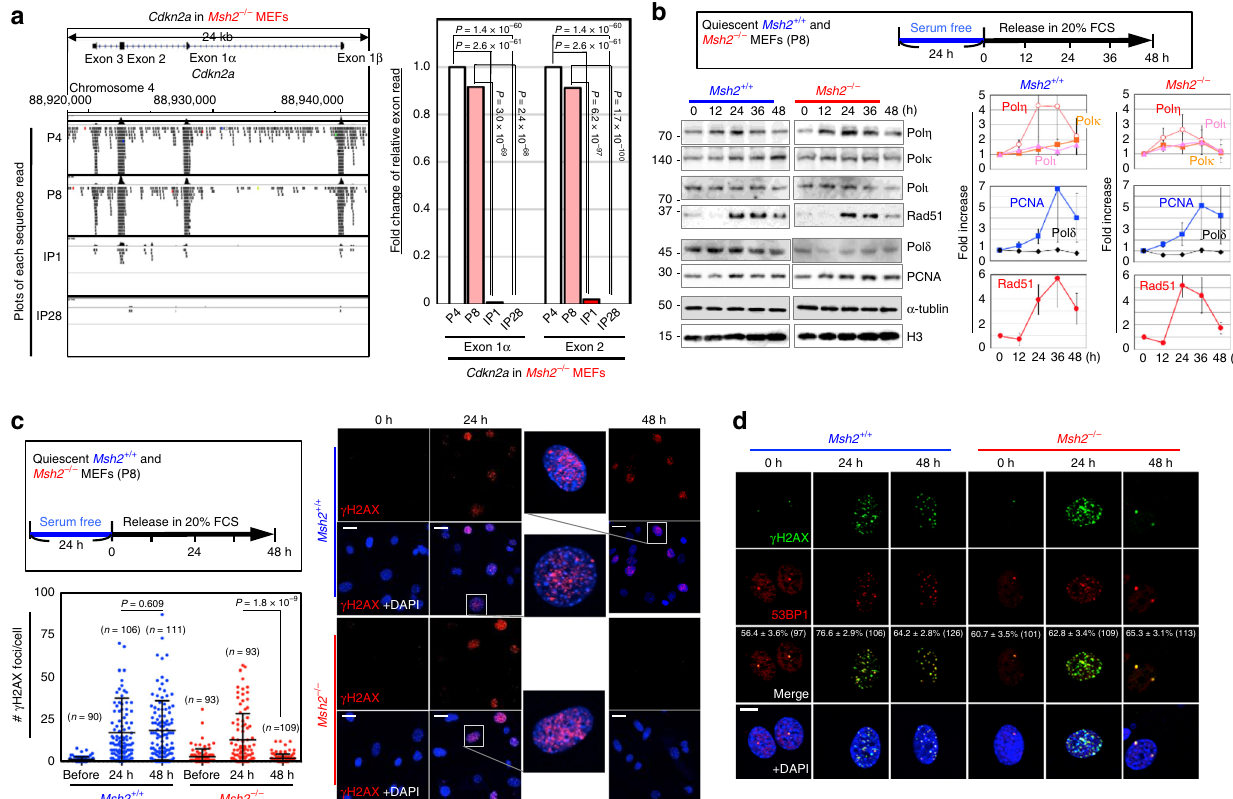
Fig. 4 Replication stress-triggered MSI/hypermutation is associated with the induction of ARF/p53-module mutations. a Individual sequence reads obtained during exome analyses were aligned onto the Cdkn2a gene locus and visualized using the Integrative Genomics Viewer at each cellular stage. Deletion status of this gene locus was also analyzed based on numbers of sequence reads at exons 1 and 2. Chi-squared test was used for statistical analysis. b Msh2 + / + and Msh2 − / − MEFs were treated as shown in the upper box. Expression of the replicative Pol δ and the TLS polymerases η , κ , and ι was analyzed by western blotting. Red arrowheads indicate the signals when each polymerase was highly expressed. Graphs show means ± s.e. ( n = 3 independent experiments with MEFs prepared from independent fetuses). c , d Msh2 + / + and Msh2 − / − MEFs were treated according to the work fl ow. γ H2AX foci were detected by immuno fl uorescence ( c , n numbers are indicated in graph). Percentages of γ H2AX foci colocalized with 53BP1 foci (means ± s.e.) are indicated in each image ( d ). Bars show means ± s.d. Scale bars, 10 μ m. Two-tailed Welch ’ s t -test was used for statistical TLS polymerases, especially pol η , which coincided with Rad51 expression (Fig. 4b). Thus, expression of low- fi delity pol η was induced at a time when γ H2AX foci were accumulated (Fig. 2c), implying that DNA synthesis could occur in the absence of proofreading and MMR. Although TLS polymerases also accumulated in Msh2 + / + MEFs, hypermutation was not detected